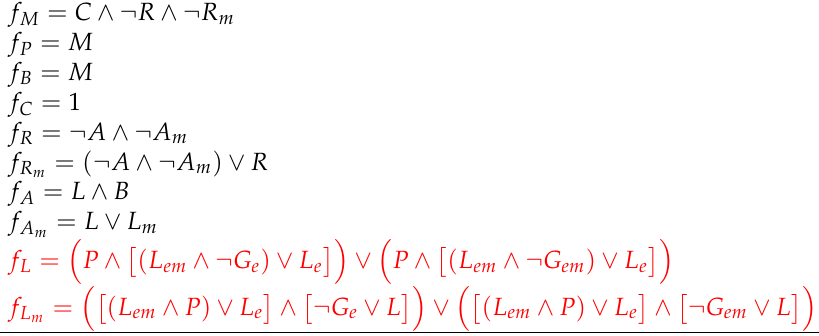
Figure 13. The improved model shown in Figure 9 (right) but with the additional parameter G em . Modified local functions appear in red.